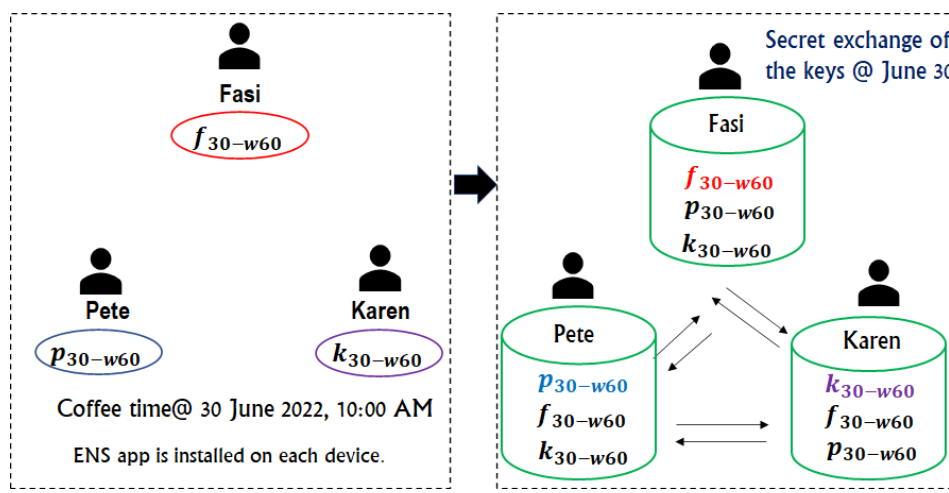
Figure 4. Example of key exchange between three friends in ENS for contact tracing